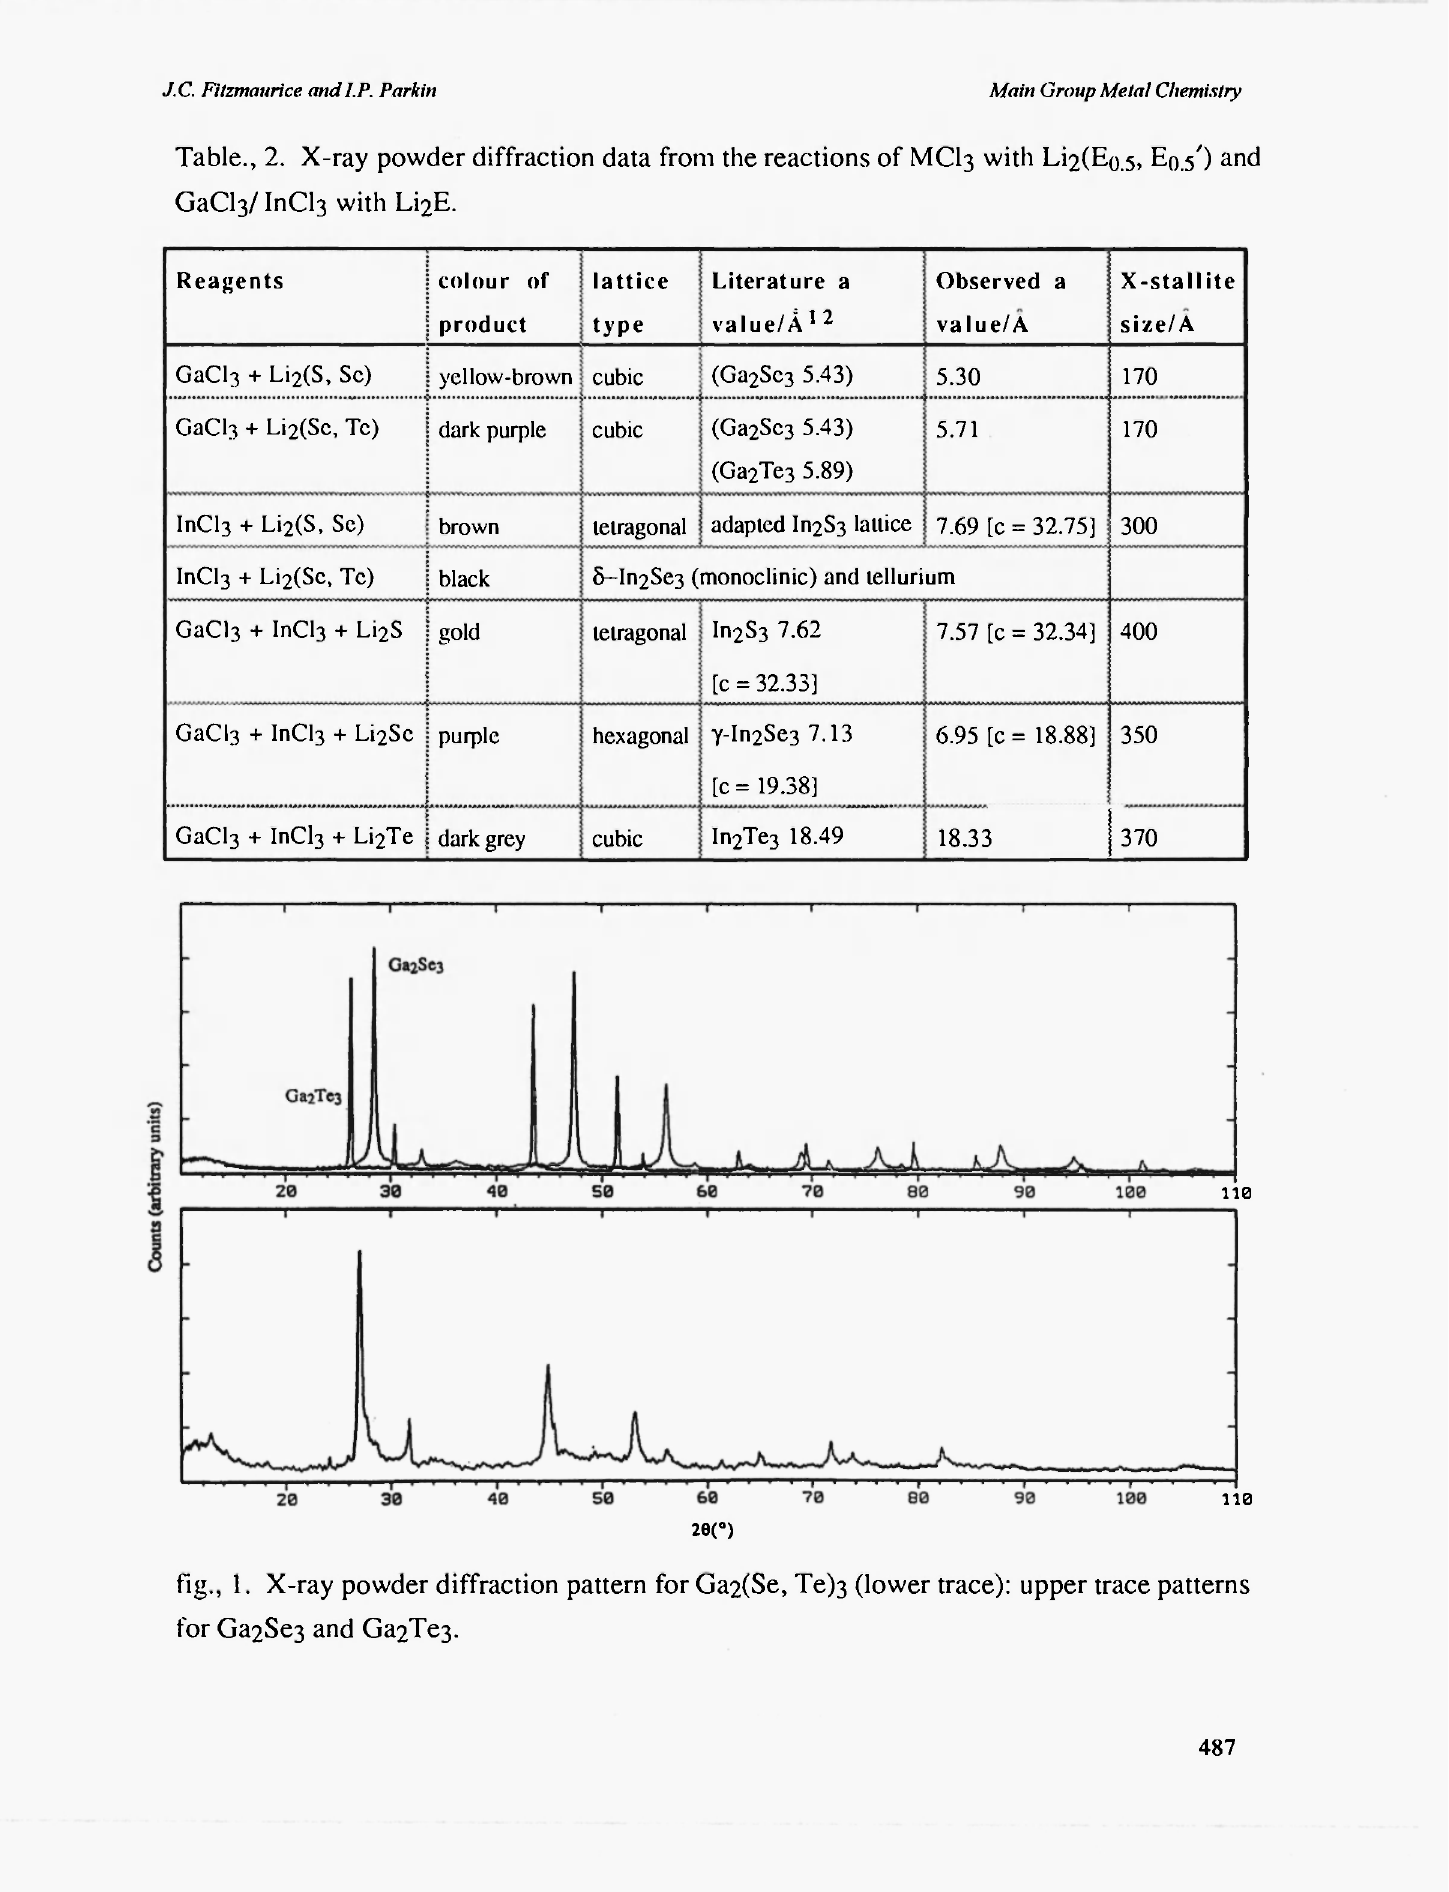
Table., 2. X-ray powder diffraction data from the reactions of 1MCI3 with Li2(Eo.5, E0.5') and GaCl / InClß with Li E. 3 2